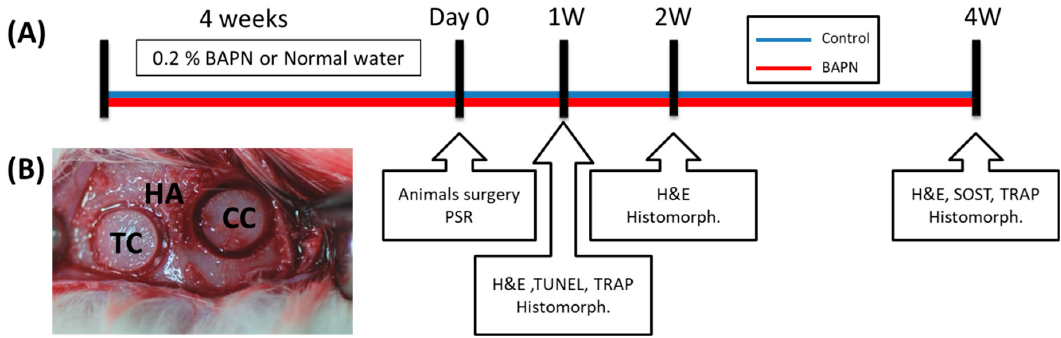
Figure 1. Schematic representation of the timeline of the experiment. ( A ) Control and beta-aminoproperionitrile (BAPN) (Test) groups and the accompanying investigation according to each time point; ( B ) Calvaria at the time of surgery. HA, host animal calvaria of either control or BAPN; CC, control chip; TC, BAPN chip.